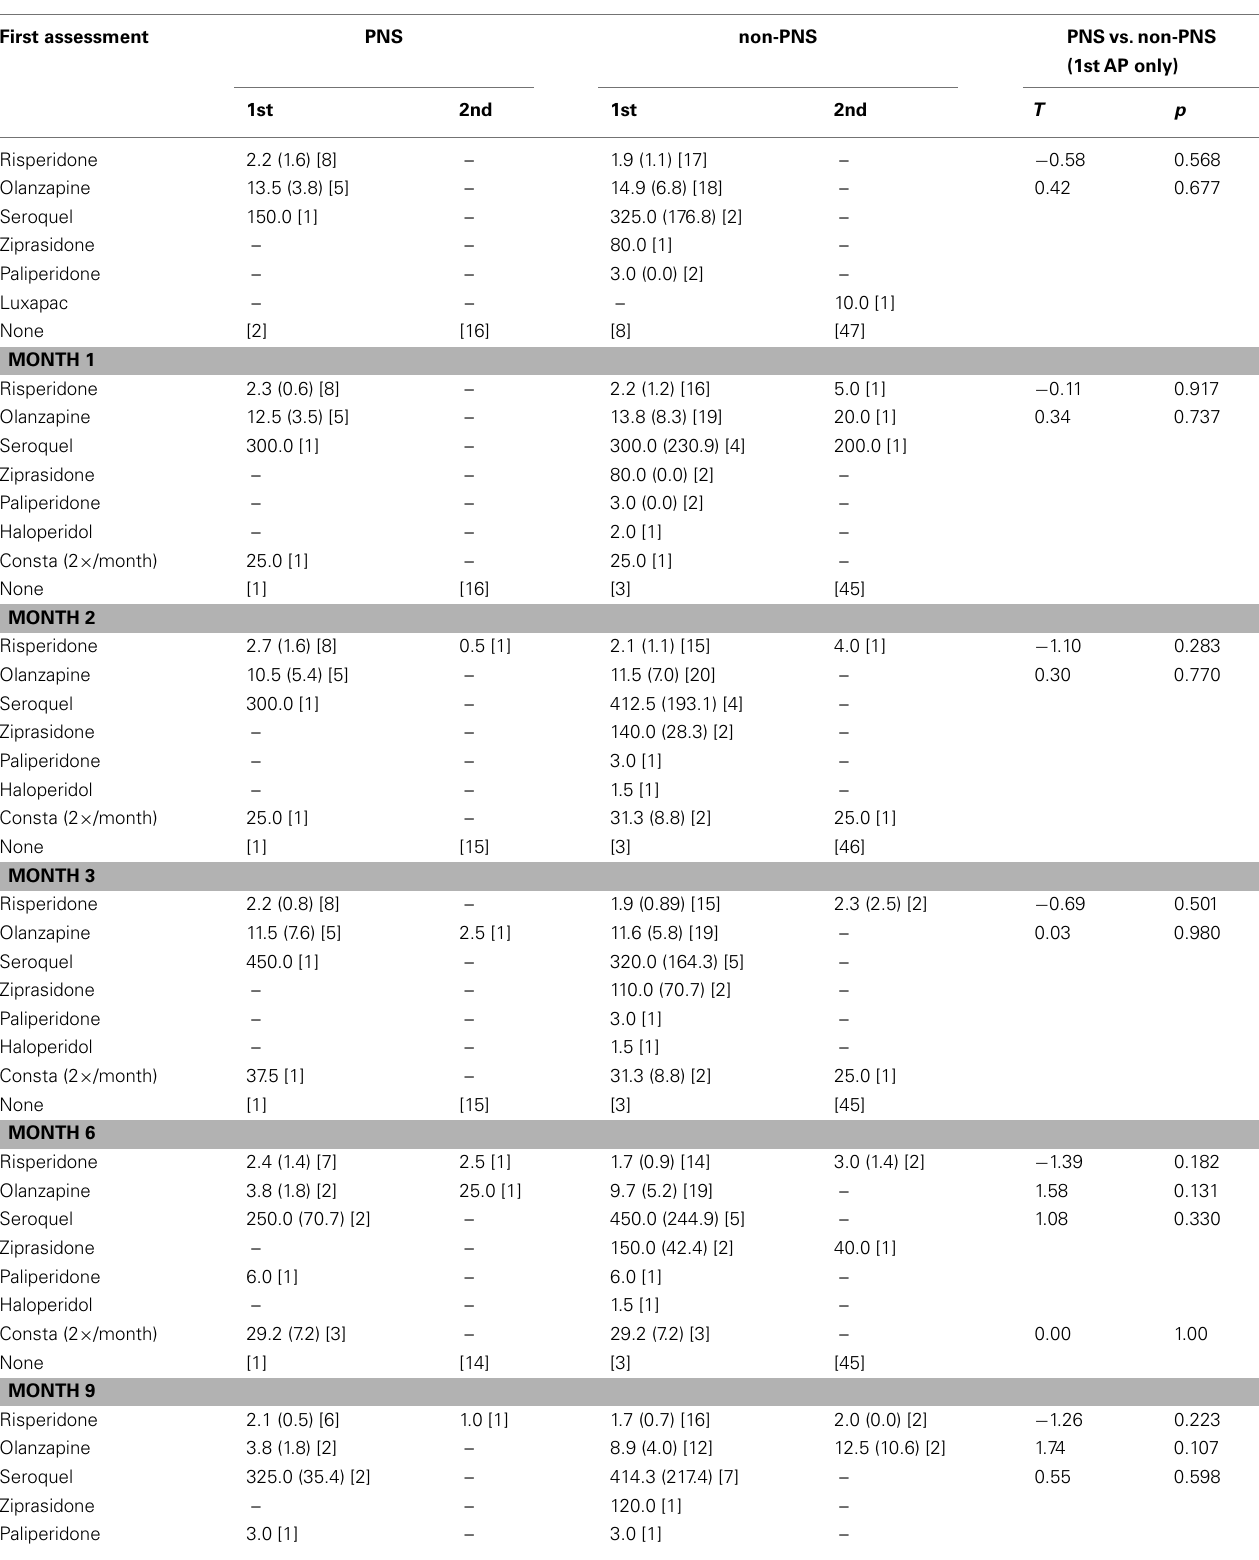
Table 4 |Types of antipsychotic medication for PNS and non-PNS